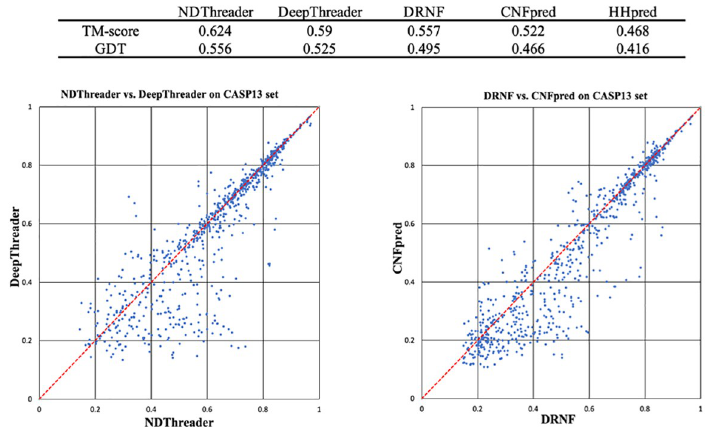
Fig 4. Alignment quality (TM-score and GDT) comparison between DRNF, CNFpred, NDThreader and DeepThreader on the CAMEO test set. Top: average alignment quality (TM-score and GDT) on the CAMEO test set. GDT is scaled to [0, 1]. Bottom left: NDThreader vs. DeepThreader. Bottom right: DRNF vs. CNFpred. Each point represents two alignments generated by two competing methods for the same protein